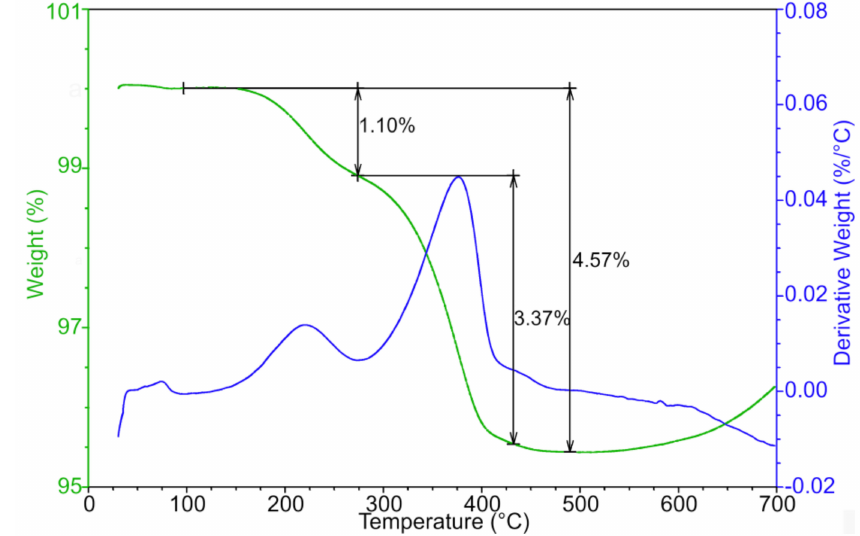
Figure 5. Thermogravimetric analysis of AW based feedstock after water debinding.